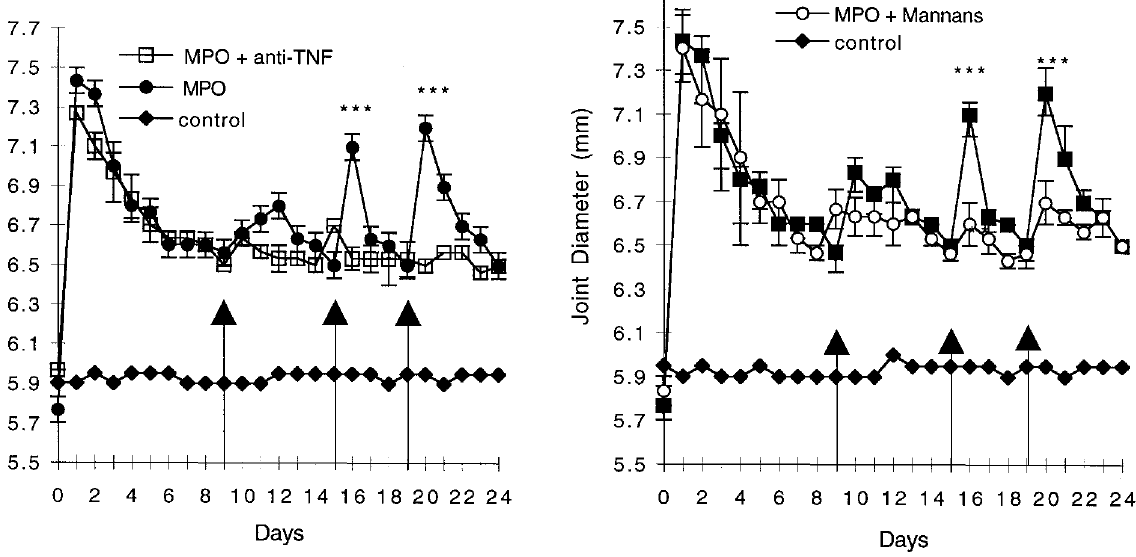
Treatment Synovial